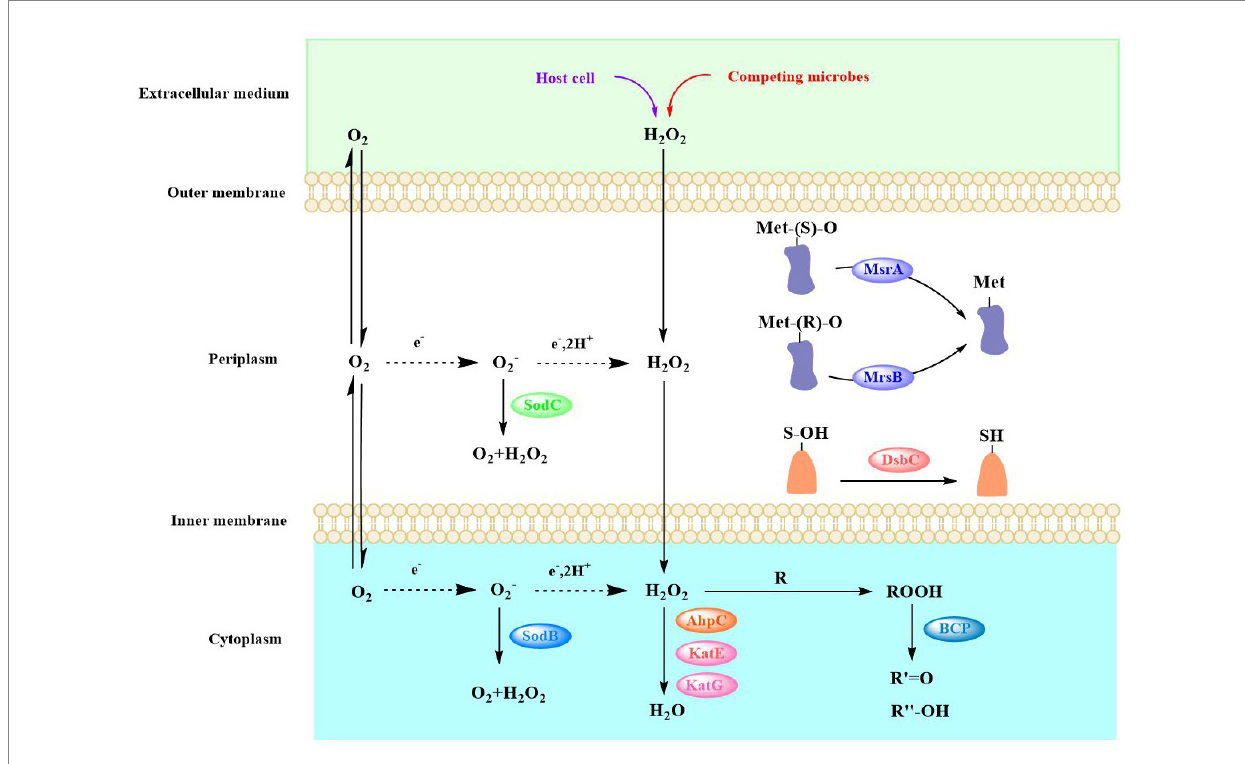
FIGURE 6 Various mechanisms that could be used by Acinetobacter to scavenge ROS and repair the membrane damage owing to ROS. ROS, reactive oxygen